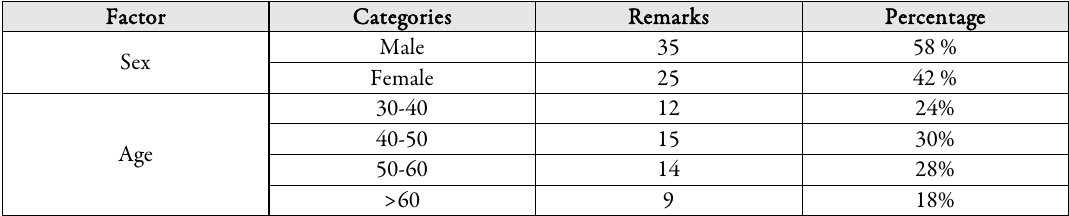
Table 1. Demographic characteristics of